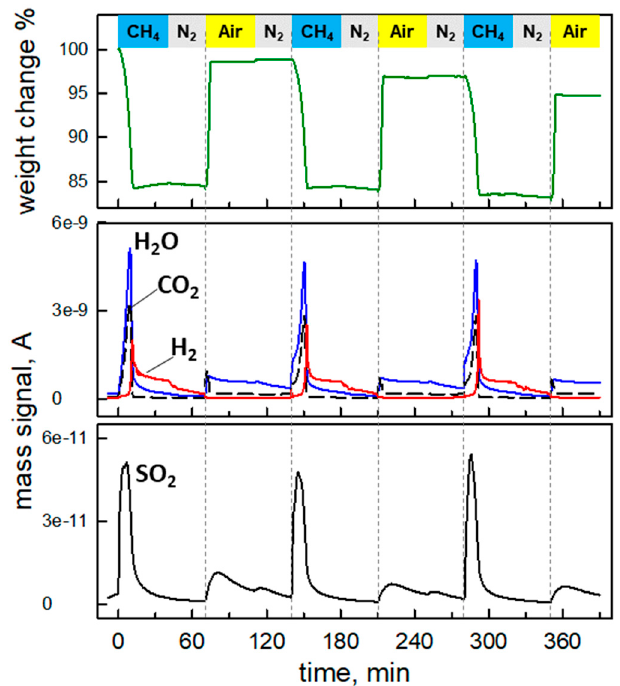
Figure 8. Weight change and gas concentration profiles during chemical looping reactions under feed stream of 5% CH 4 /N 2 and air at 900 ◦ C over Co-La 2 O 2 SO 4 cycled feed stream of 5% CH 4 /N 2 and air at 900 °C over Co-La 2 O 2 SO 4 .